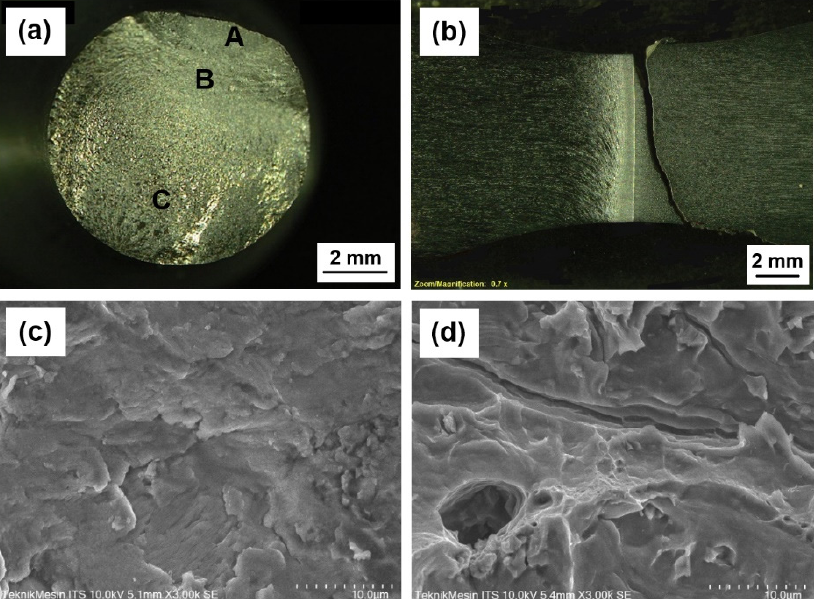
Figure 15. Fracture surfaces of the weld joint produced at the rotational speed of 1200 rpm after a high cycle fatigue testing taken from: ( a ) cross section and ( b ) parallel section of the welded rod with ( c , d ) SEM fractographs obtained from the regions marked A and B in Figure 15a, respectively.